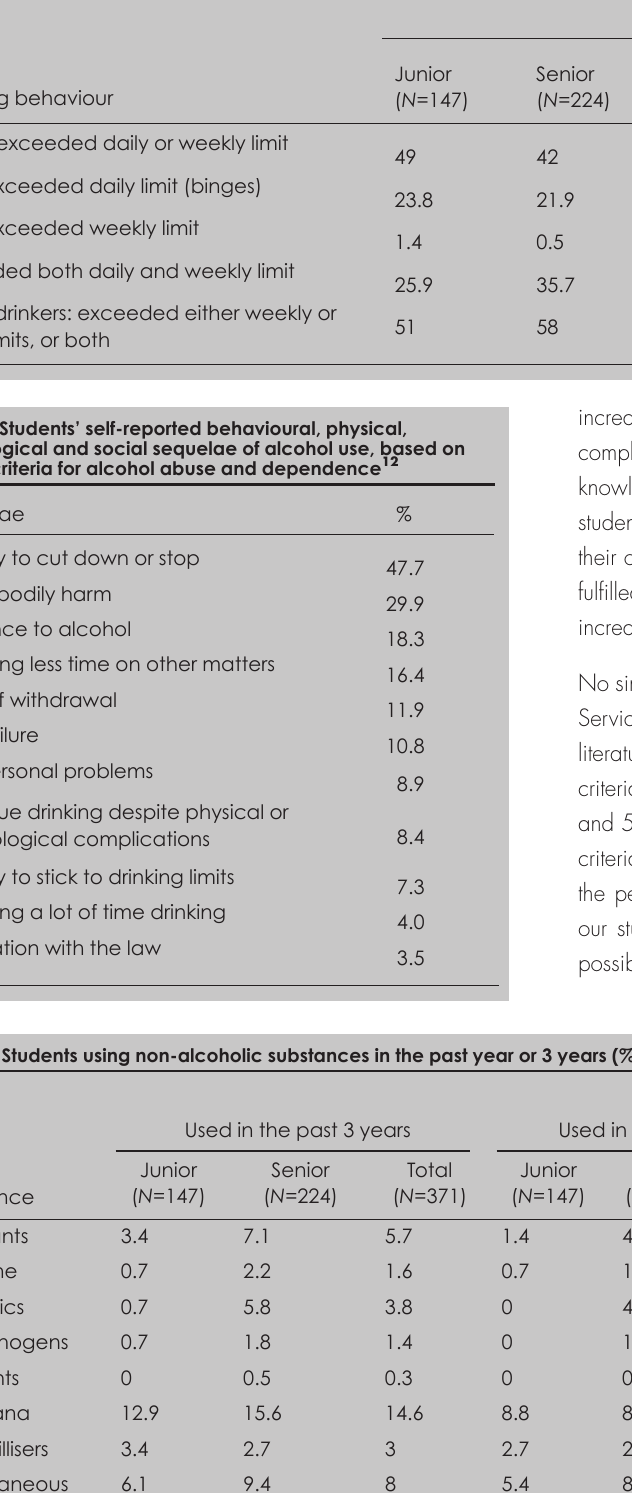
Drinking behaviour